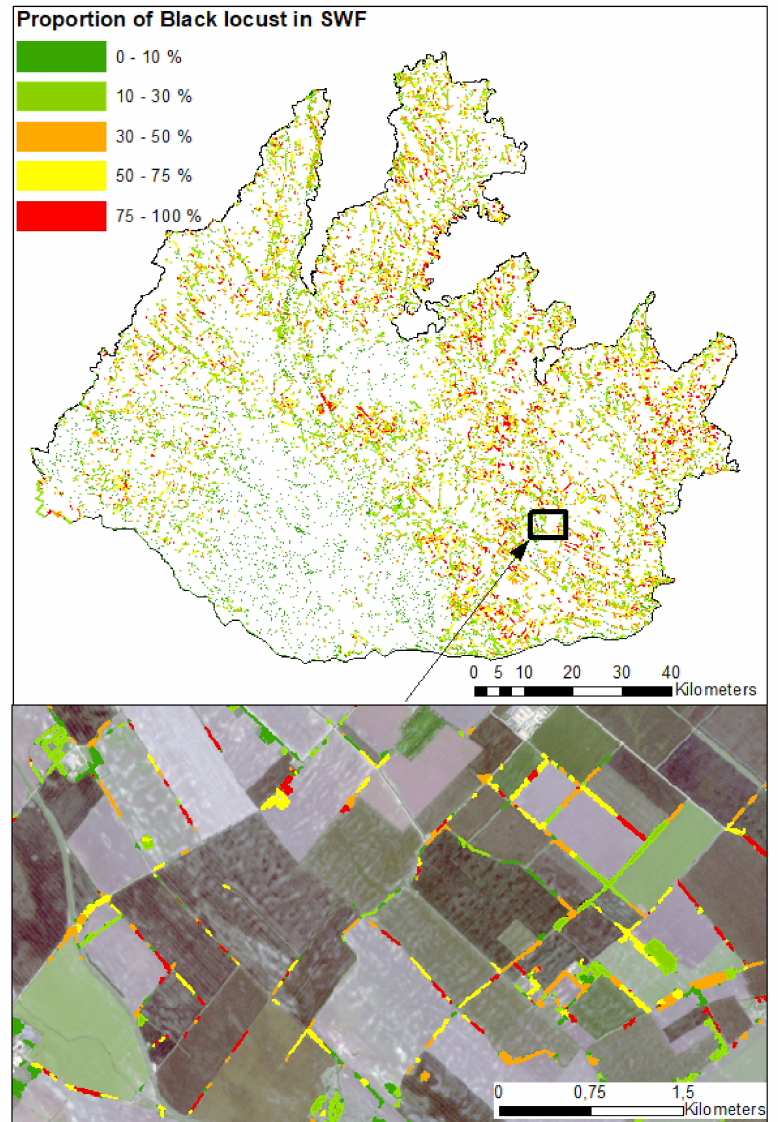
Figure 11. Map of black locust proportion in small woody features.